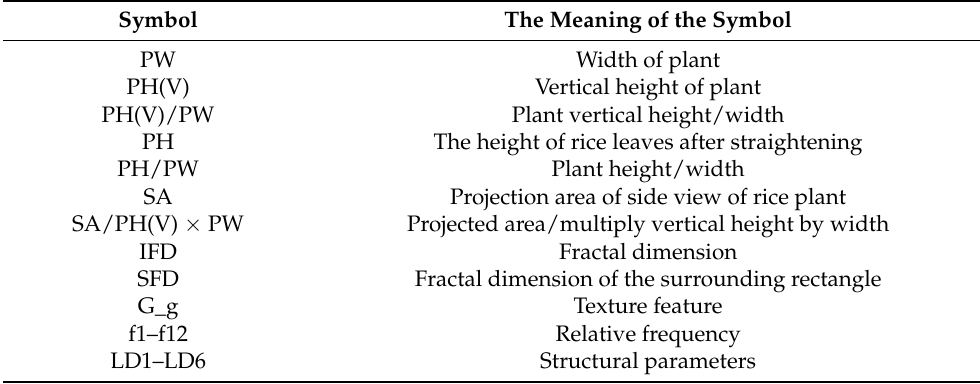
Table 1. Characterization of rice and its corresponding